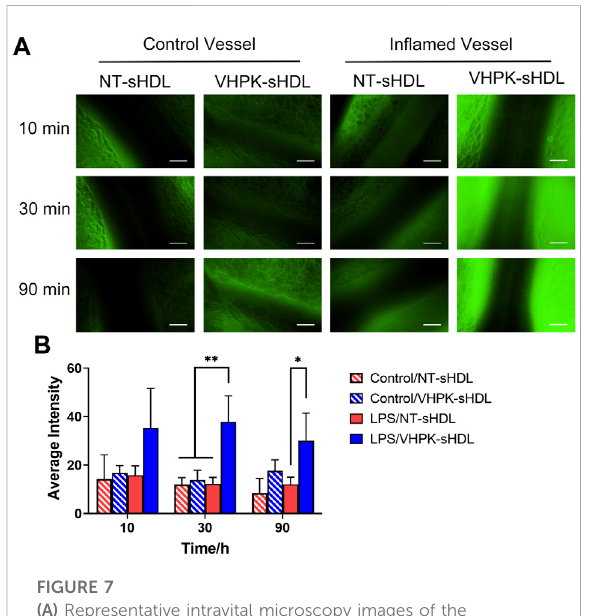
FIGURE 7 (A) Representative intravital microscopy images of the endothelial distribution of NT-sHDLs and VHPK-sHDLs. Scale bar represents 50 μ m. (B) Average fl uorescent intensity on mice